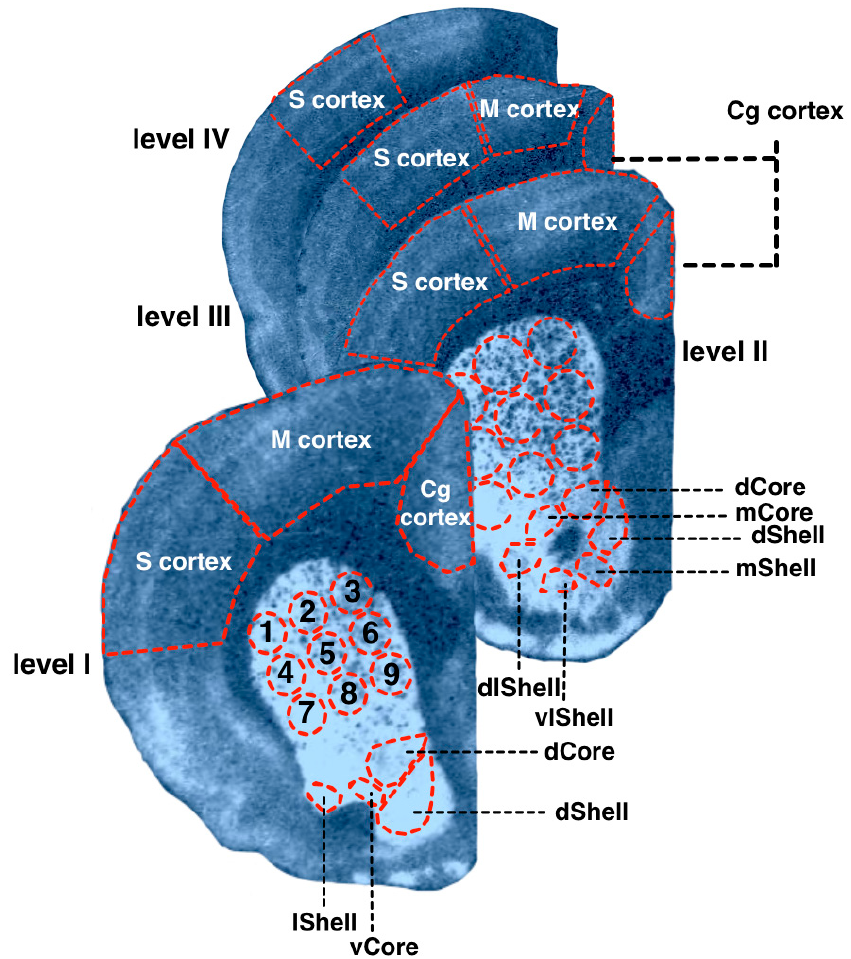
Figure 2. Examples of the autoradiographic imagiing of [3H]spiperone binding densities in the coronal sections of the WS rat brain at the following anatomical levels: +2.4 (level I); +1.68 (level II); − 1.08 (level III); − 2.16 (level IV) relative to bregma. The rat brain atlas [25] was used to identify and mark brain structures. 1–9—dorsal striatum spatial subregions; Core—nucleus accumbens core;